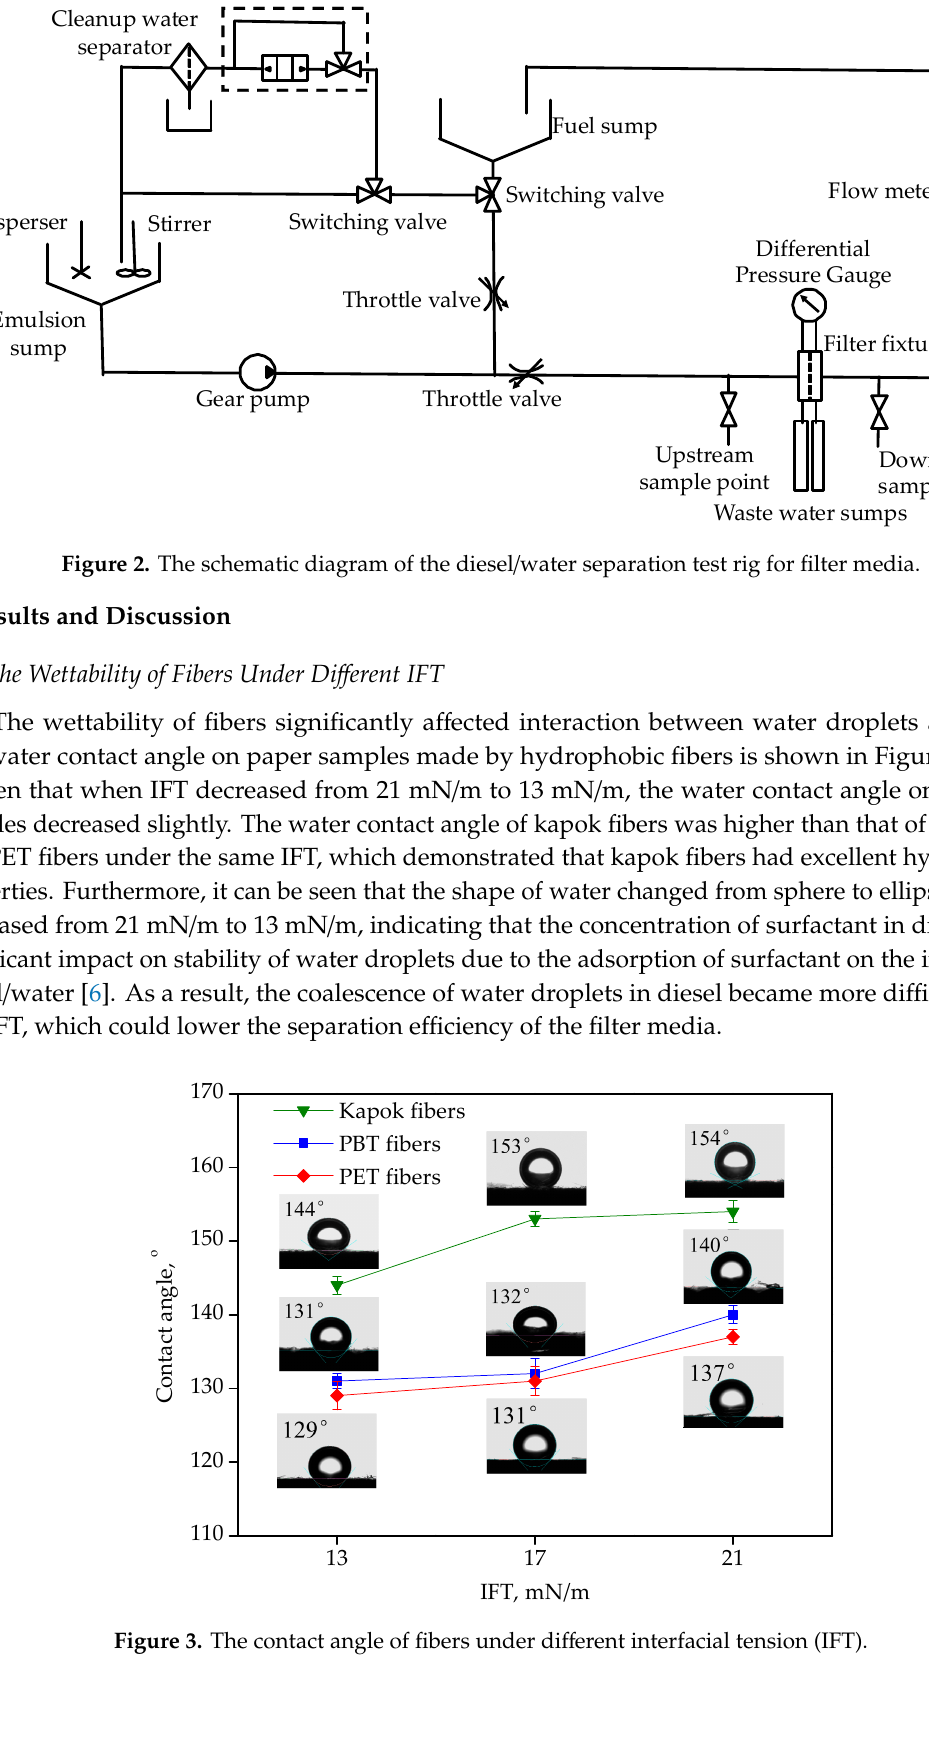
( c5 ) 600 s Figure 4. The water contact angle on samples made by glass microfibers: ( a ) IFT = 21 mN/m; ( b ) IFT = 17 mN/m; ( c ) IFT = 13 mN/m 3.2. The Physical Properties and Morphology of Filter Media Containing Kapok Fibers The basic properties of filter media with different content of kapok fibers are shown in Table 3. As shown in Figure 5, the mean pore size of upstream layer (9.6 μ m–11.3 μ m) was slightly larger